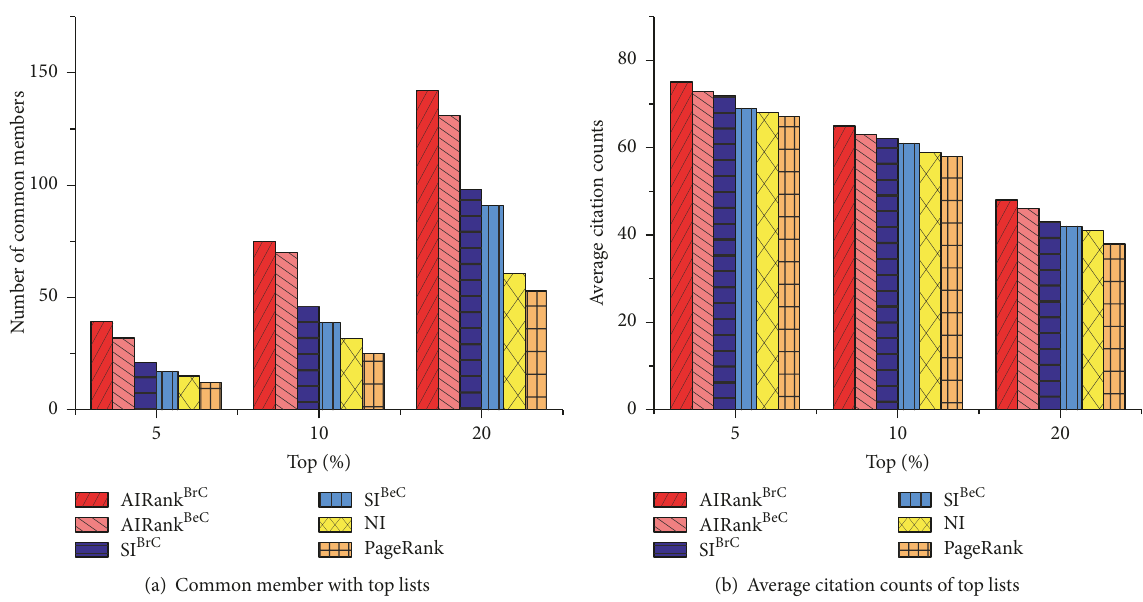
Figure 7: The performance of top ranking scholars by SI BrC , SI BeC , NI, AIRank BrC , and AIRank BeC